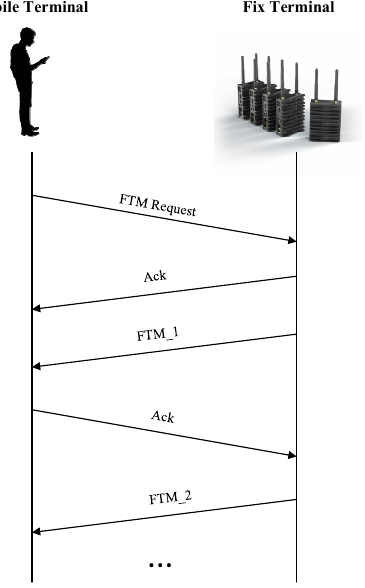
Figure 1. Procedure of Wi-Fi fine timing measurement (FTM).